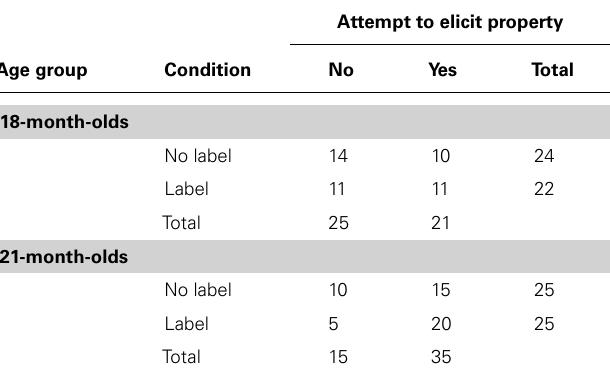
Table 2 | Extension trial: Learning as a function of condition and age